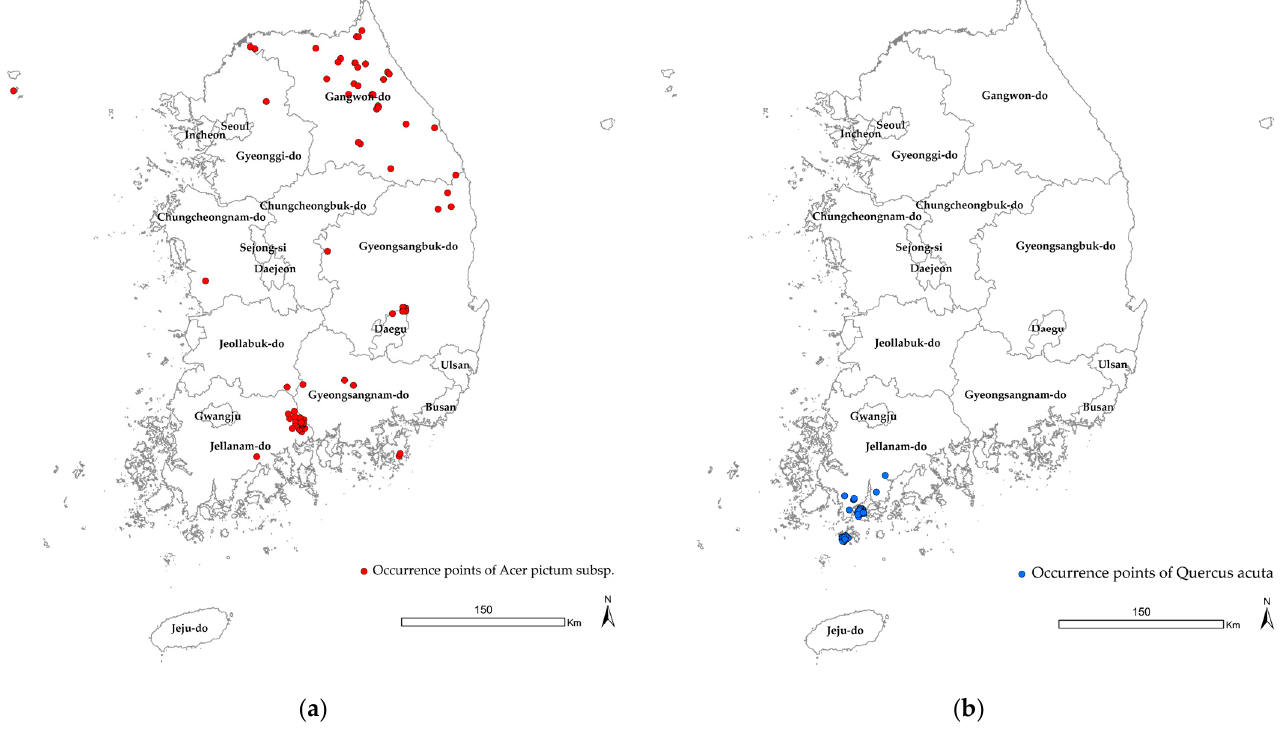
Figure 1. Species occurrence point: ( a ) A. pictum ; ( b ) Q. acuta . Table 1. Environment variables entered into the